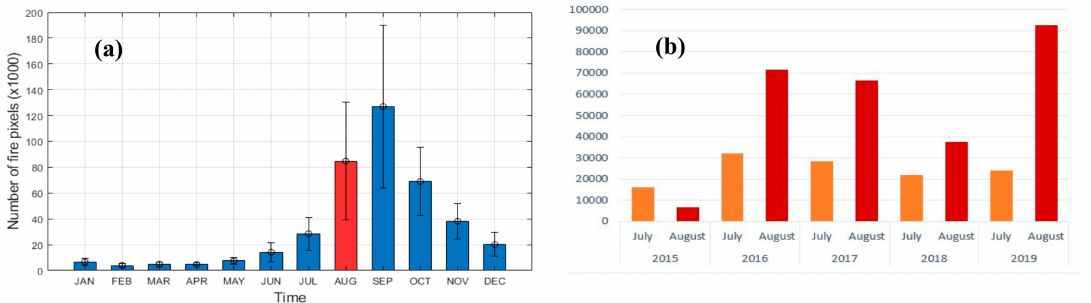
Figure 2. ( a ) Monthly fire pixels averaged over the 2002–2019 period from MODIS over Brazil. The vertical bars show the ± 1 σ variations. ( b ) July (in orange) and August (in red) cumulated fire pixels as detected by MODIS over Brazil from 2015 to